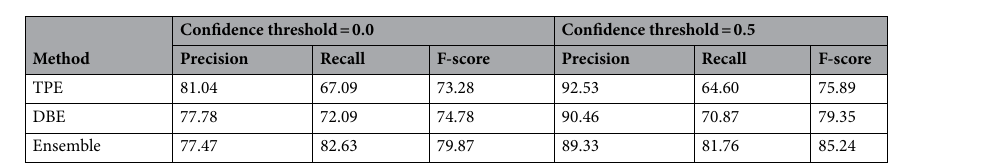
Table 2. Performance evaluation for extracting relation words between microbe and disease entities. TPE structural pattern matching only, DBE dependency-based extraction only.